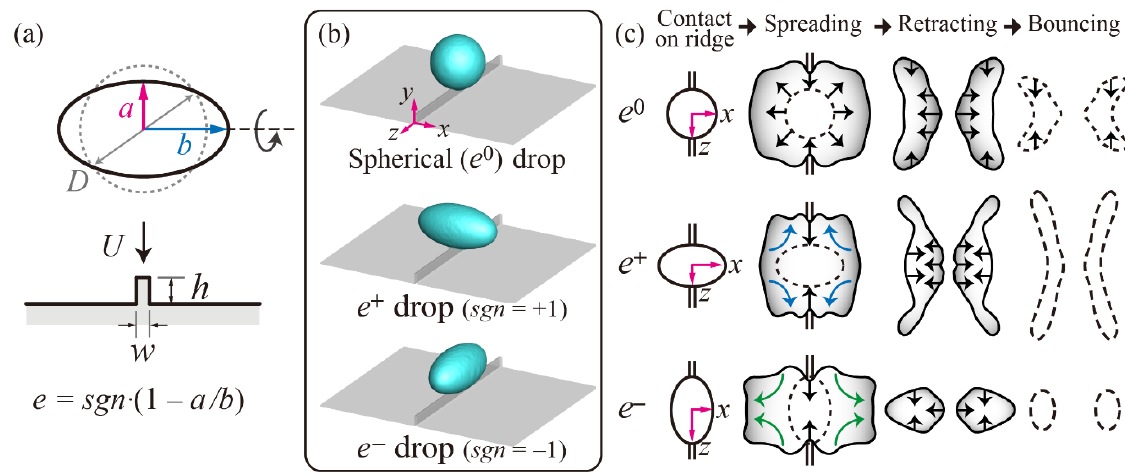
Figure 2. ( a ) Schematic of ellipsoidal drops impacting on non-wettable ridged surfaces with an initial velocity, U . The ellipsoidal drop’s ellipticity in the study is controlled as e = ±0.47. ( b ) Geometrical configurations of spherical and ellipsoidal ( e + and e − ) drops with respect to the ridge. ( c ) Illustration of general evolution of water drop based on contact, spreading, retraction, and bouncing: reused from [25], Copyright (2021) with permission from Elsevier.